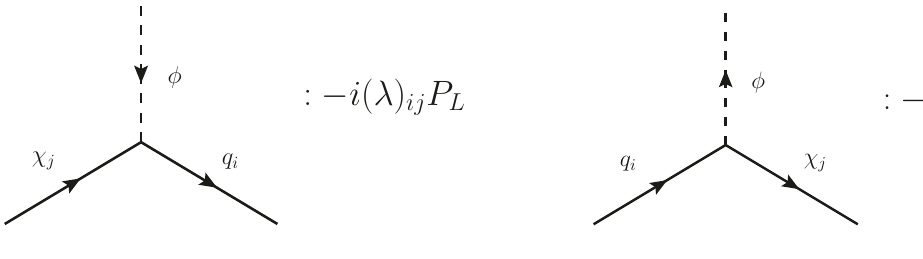
Figure 1 . Feynman rules for the interaction in eq. (1.2).